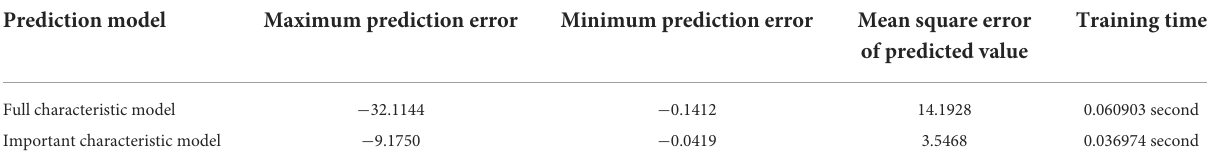
TABLE 2 Comparison of two prediction